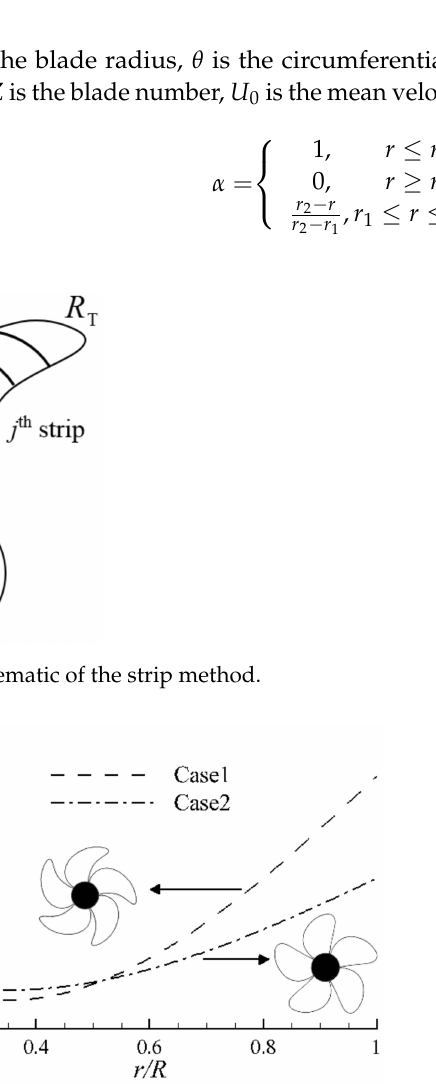
Figure 3. Skew distributions in Case 1 and Case